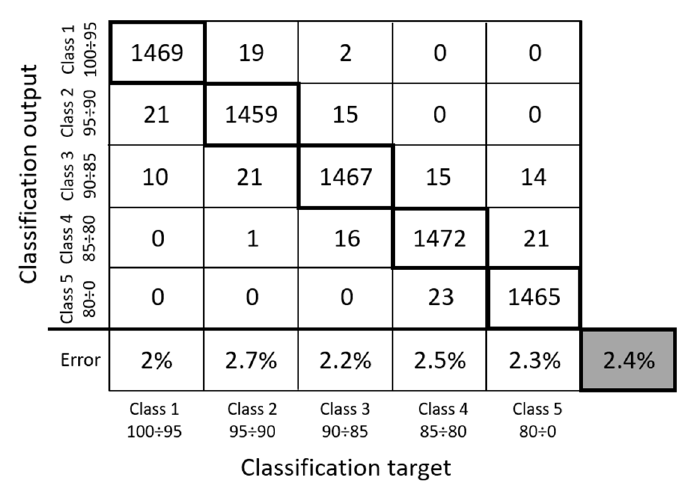
Figure 7. Evaluation of the SOH classification performance. Confusion matrix obtained for the ANN trained with the scaled conjugate gradient (SCG) algorithm. The cell in the grey background indicates the overall accuracy of the method.